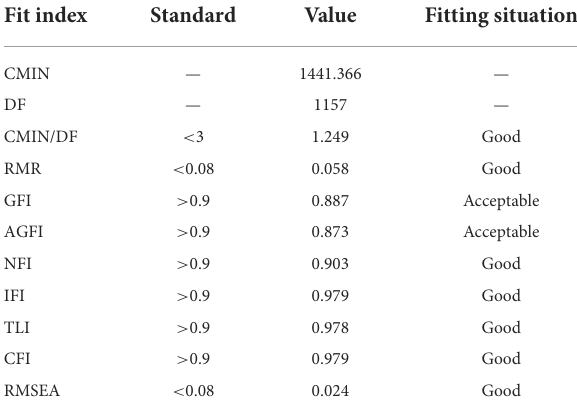
TABLE 5 Model fit index.